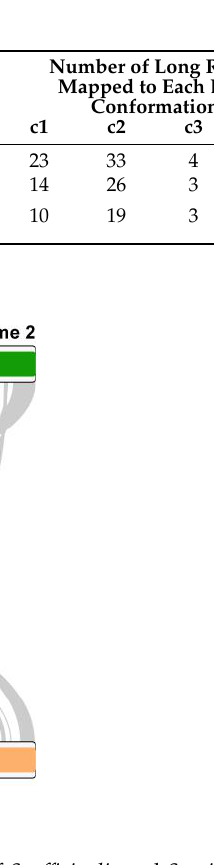
Table 1. Mapping results for Nanopore long reads to the four possible conformations associated with three DBS (DBS01–03), which correspond to high-scoring sequence pairs (HSPs) r01, r02, and r47 described in Section 2.3. DBS: double-bifurcation structure. MC1/2: mitogenome chromosome 1/2. The percentage of minor DBS conformations was calculated as the number of reads mapped to the conformations having fewer mapped reads divided by those mapped to all conformations.